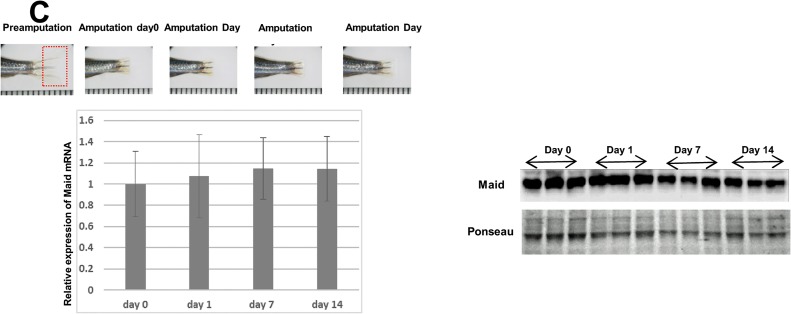
Maid expression following partial hepatectomy or fin amputation in zebrafish.(A) Top: Diagram of the area of adult zebrafish liver subjected to PH. Middle: Macroscopic views of fish abdomens, sliced in the middle. About 30% of the ventral lobe of the liver was removed. The area of the liver regeneration is demarcated by a rectangle. Bottom: Macroscopic view of the livers in the middle panel after 7 days of regeneration. Results are representative of 10 fish per group. (B) Left: RT-PCR analysis of Maid mRNA expression in regenerated zebrafish liver at the indicated times after PH. Results are the mean ± SD expressed relative to Gapdh and are representative of at least 5 fish per group, *, p<0.05. Right: Western blotting analysis of Maid in regenerated zebrafish liver. (C) Left Top: Macroscopic views of a representative adult zebrafish tail fin before and after amputation. Fin regeneration was monitored for 14 days. Left Bottom: RT-PCR analysis of Maid mRNA expression in regenerating fin at the indicated times after fin amputation. Results are the mean ± SD (n = 3/group) and are expressed relative to El1a mRNA in fish at Pre-Amputation. Right: Western blotting analysis of Maid in regenerating fin.